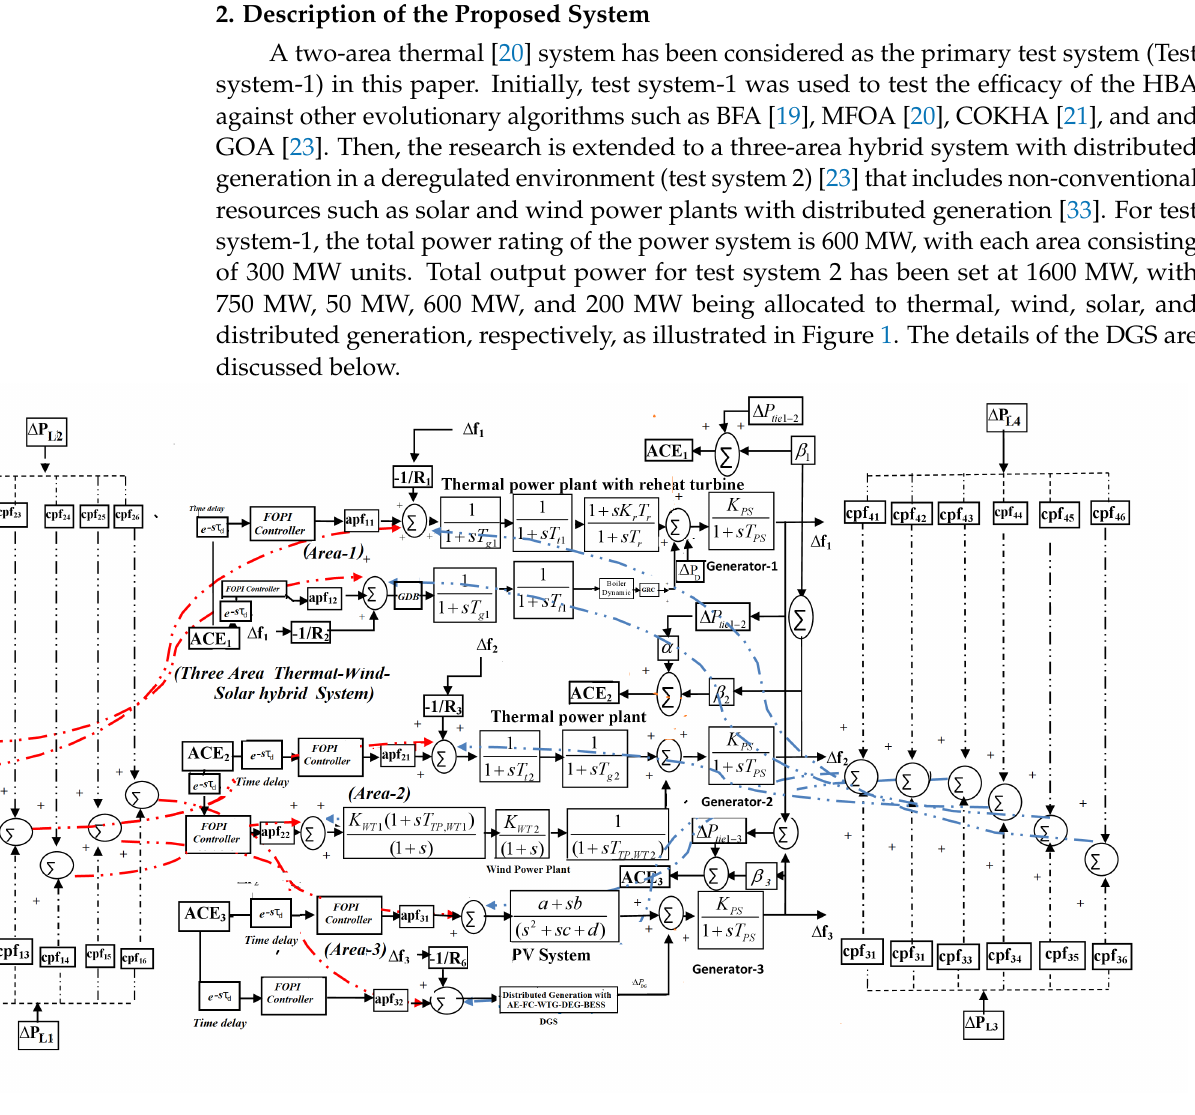
Figure 1. Linearized model of three − area renewable − based (Solar − PV) system with distributed